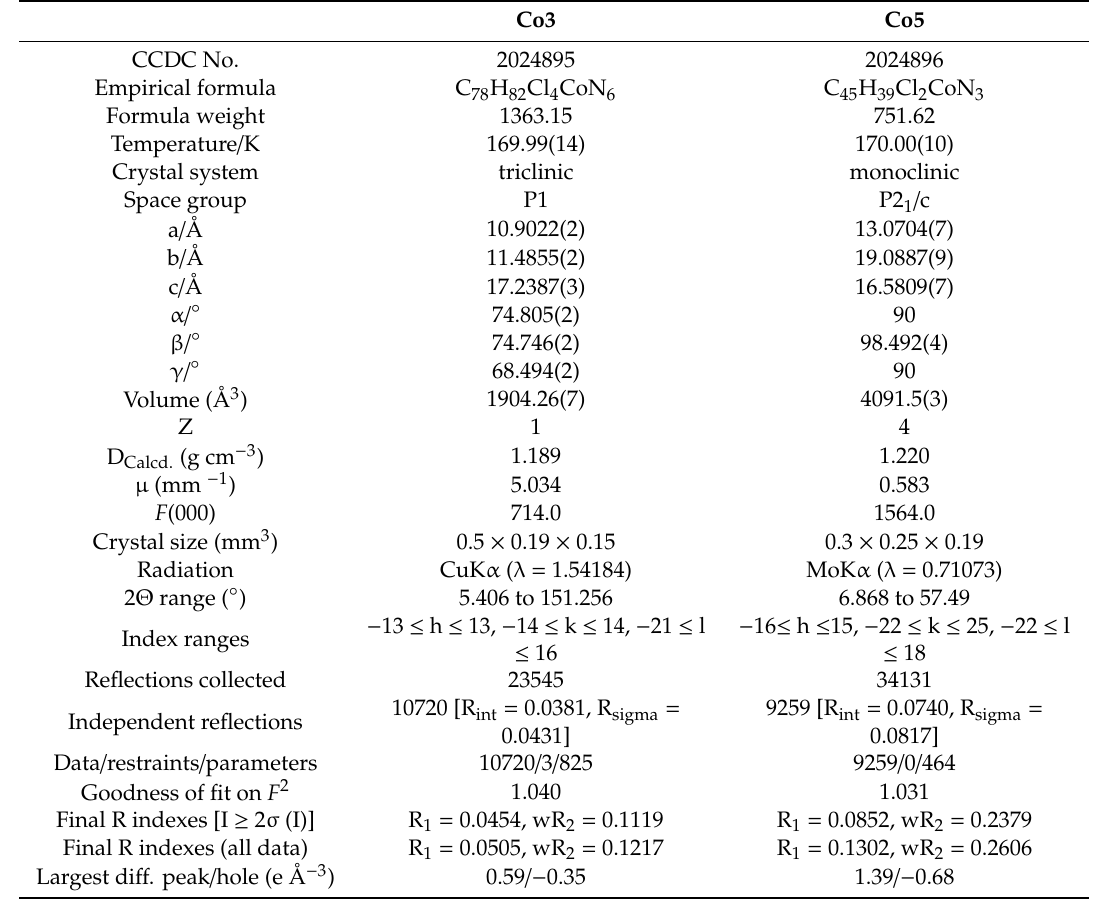
Table 4. Crystal data and structure refinement for Co3 and Co5